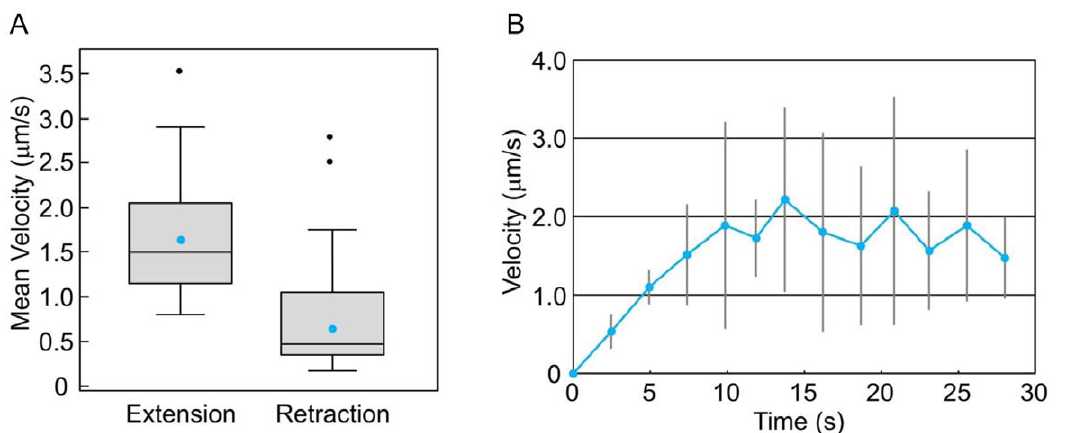
Figure 4. Dynamics of protrusions during amoeboid movements. By using the images obtained by ezDSLM, velocities of extending or retracting protrusions were measured. (A) Mean velocities of protrusions during extension or retraction are shown in box plots. Blue and black dots indicate mean values and outliers, respectively. The mean velocities of extension and retraction were significantly different by t-test (p , 0.01). Data from 25 protrusions for each category are shown. (B) Time-evolved velocities of extending protrusions. Data from 5 protrusions are shown as mean 6 SD. Fig. S1. Exposures of CCD camera were synchronized to the line